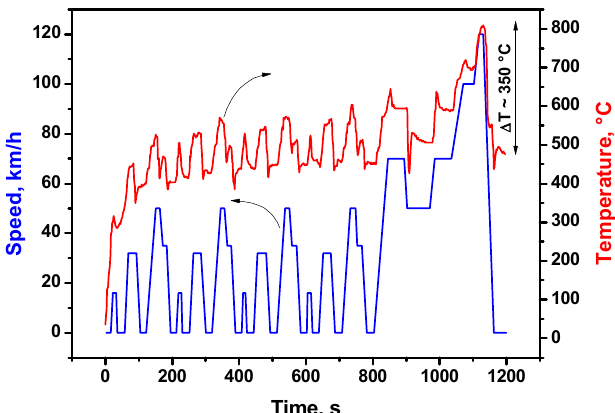
Figure 2. The speed and temperature profiles for the driving cycle (roll tests) of the monolith-supported catalysts.